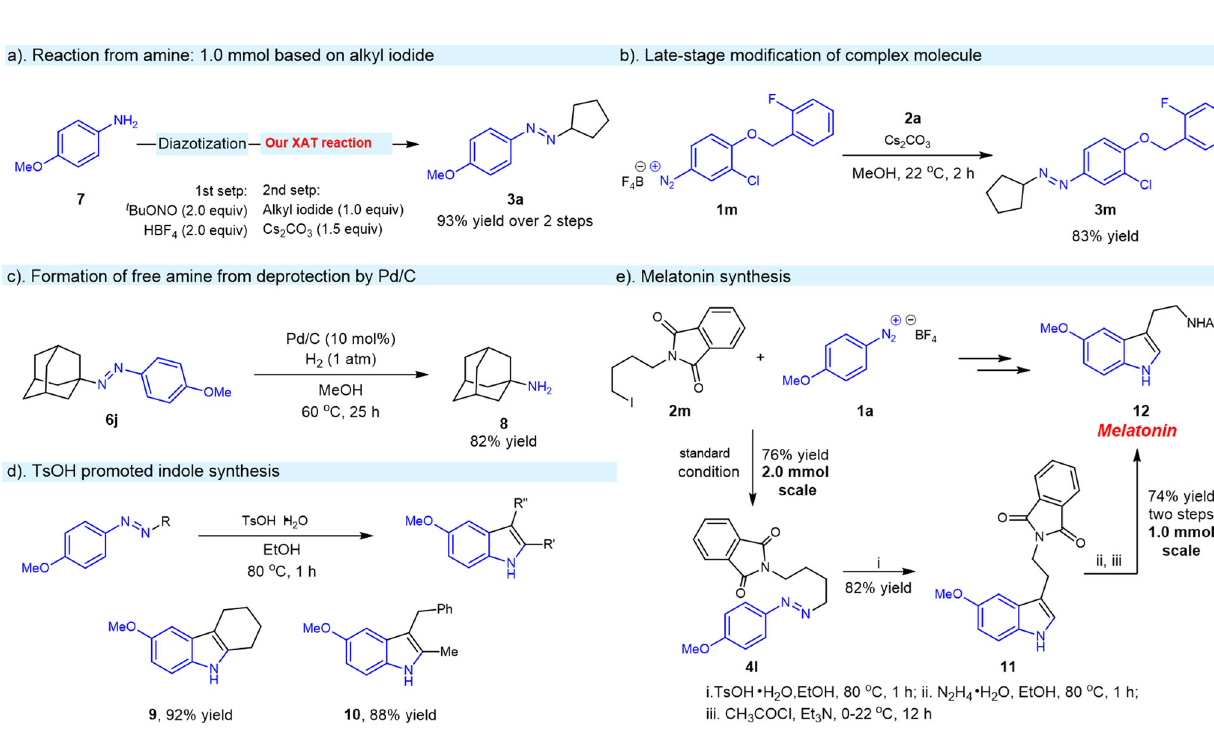
Nature Communications| (2022) 13:7961